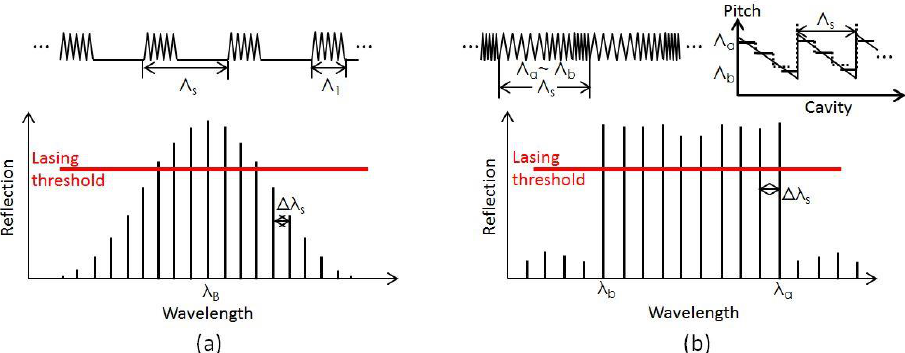
Figure 1. ( a ) Sampled grating structure and its reflectivity spectrum; ( b ) superstructure grating structure and its reflectivity spectrum.